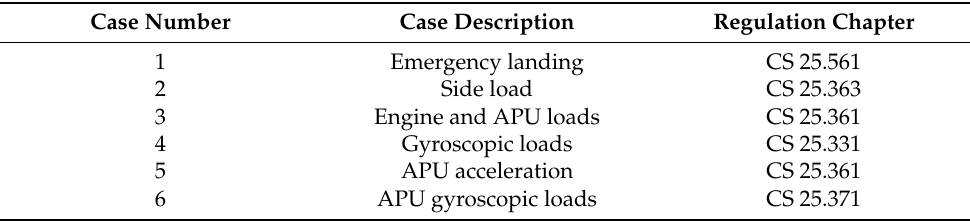
Table 6. Fuselage fan integration structural load cases according to CS-25 (cf. [76]).